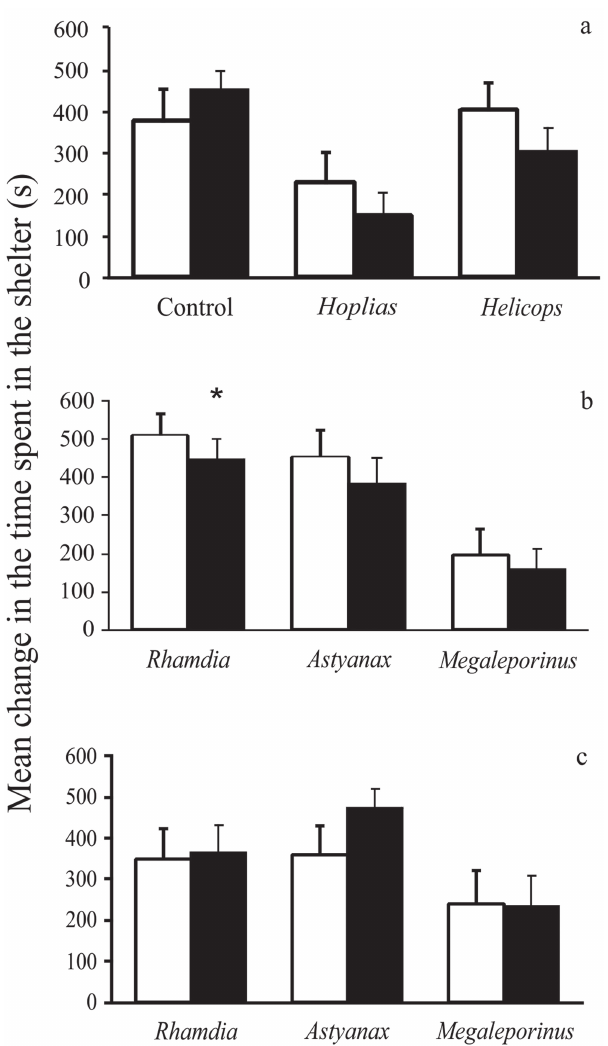
Fig. 1. Mean (± SE) in the time spent in the shelter by juvenile catfish after exposure to a. odor of predators Hoplias malabaricus and Helicops infrataeniatus ; b. odor and c. skin extract of conspecifics and non-predators Astyanax lacustris and Megaleporinus obtusidens . Open bars = pre stimulus; solid bars = post-stimulus; *indicates a significant difference (p < 0.05).